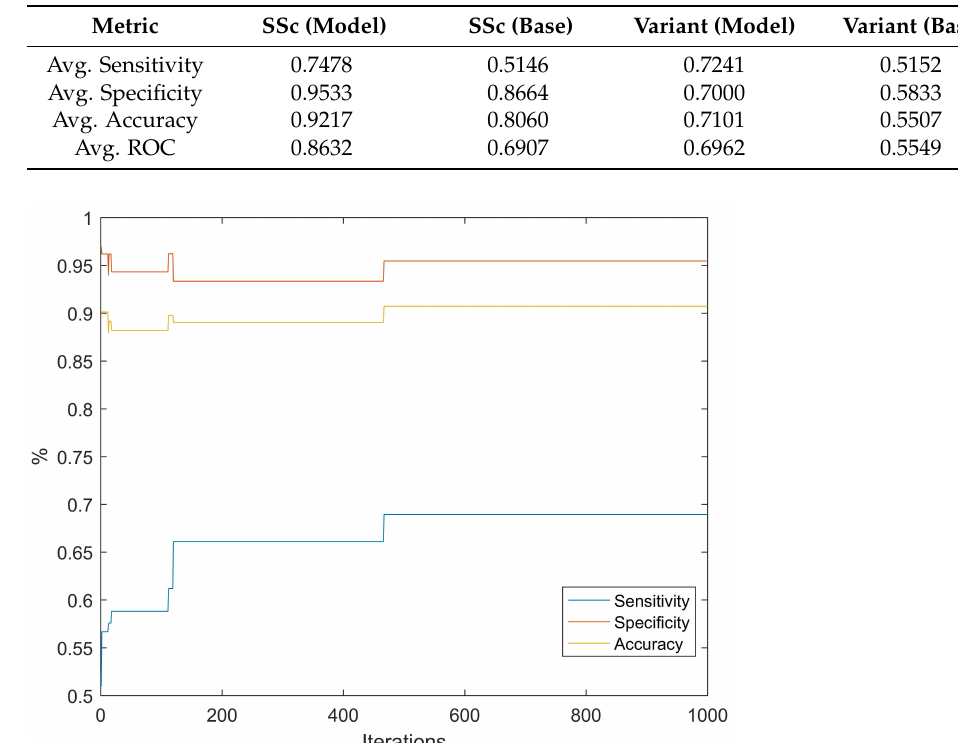
Figure 3. ROC sample for one iteration. Table 3. Average precision of the model distinguishing SSc and control patients as well as SSc variants (diffuse vs. non-diffuse).